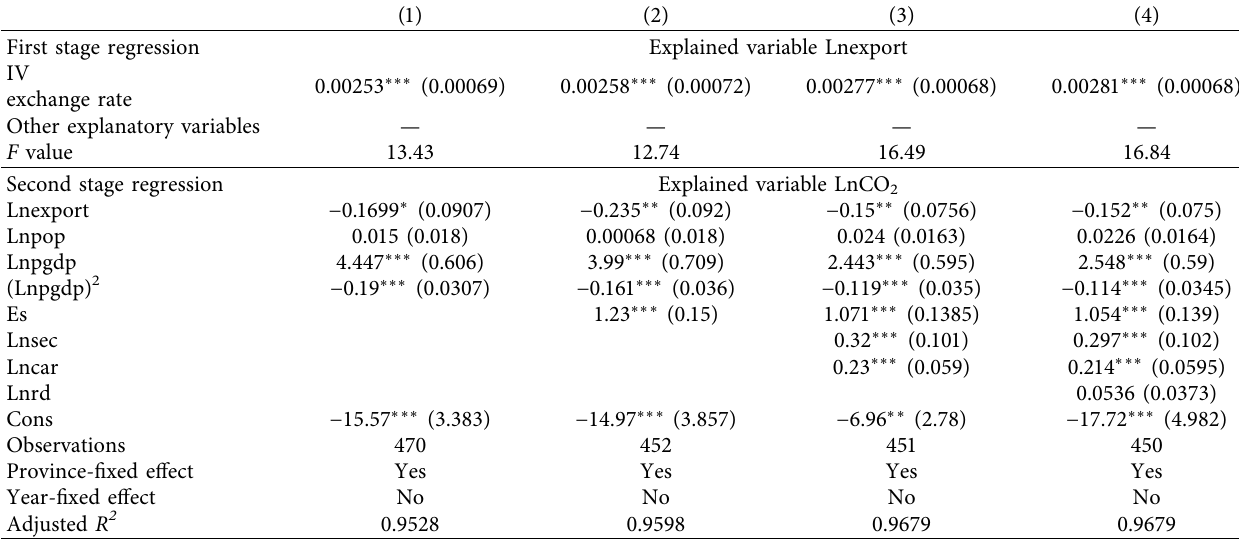
Table 4: Robustness test of changing the core explanatory